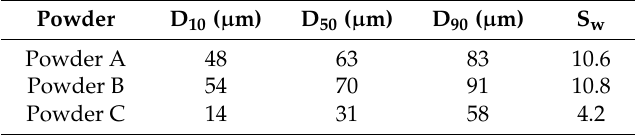
Table 1. Particle size distribution of the tested powders A, B, and C.